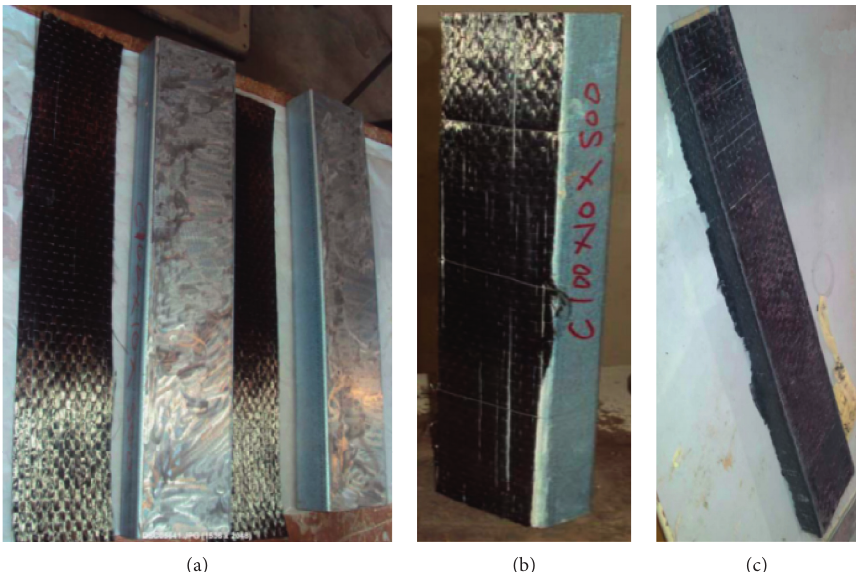
Figure 6: Cold-formed thin-walled steel strengthened by CFRP [19]: (a) plain section; (b) CFRP-strengthened web; (c) CFRP-strengthened full section.